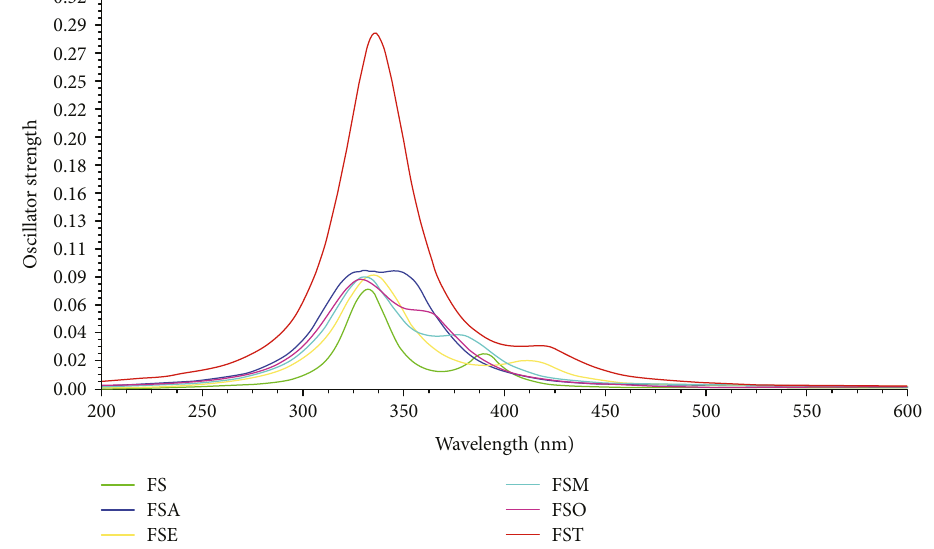
Figure 4: The maximum wavelength and oscillator strength of all fl uorescein dye derivatives in the gas phase.